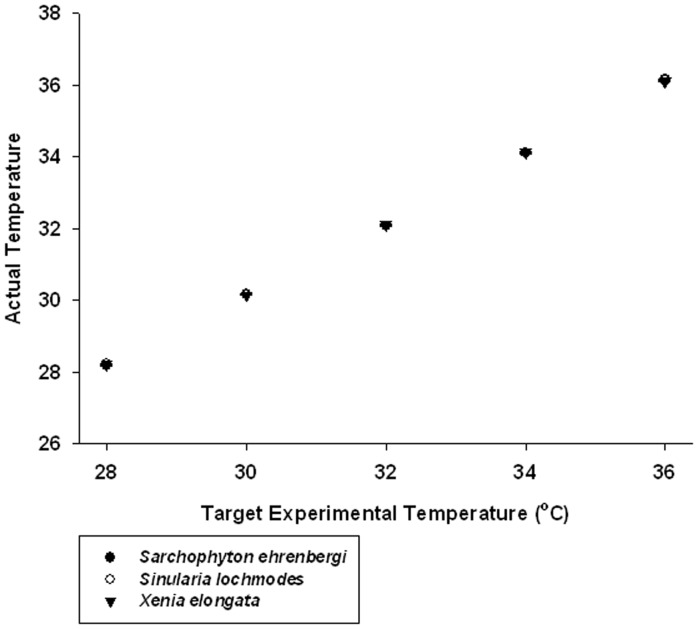
Graph of the relationship between target temperatures in this experiment (28, 30, 32, 34, and 36°C) vs. the actual measured temperature values.Means and 95% confidence limits shown. Each mean is a grand mean of 360 values measured over 10 trials (ni = 36) for each temperature. Values plotted for the three alcyonacean soft coral species encompassed in this experiment: • = Sarchophyton ehrenbergi, ○ = Sinularia lochomodes, and ▾ = Xenia elongata. Points overlay each other. 95% confidence limits are so small that they are difficult to discern and are obscured by the points, indicating that experimental temperartures were close to target values and precise.